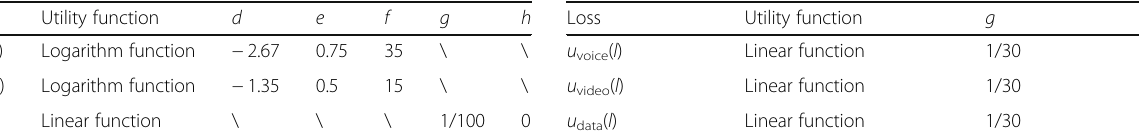
Table 4 Utility function for packet loss ratio and